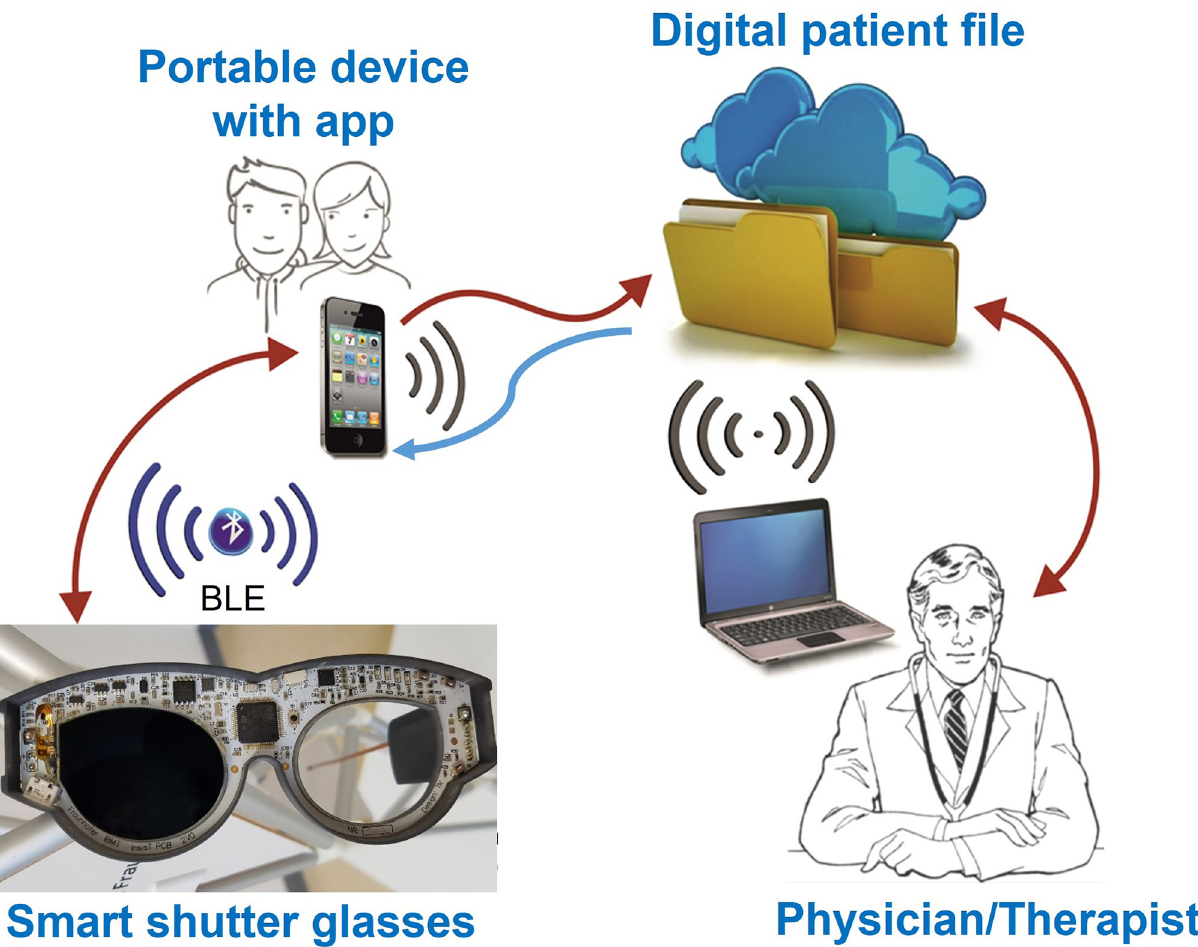
Fig 8. Illustration of the digital therapy system design. The smart shutter glasses, equipped with multimodal sensors and patient feedback, communicate bidirectionally with a smartphone via Bluetooth interface. The parents use the app for therapy monitoring. The smartphone securely transmits relevant data to a digital patient file accessible via the Internet, which in turn can be viewed by the attending physician/therapist.